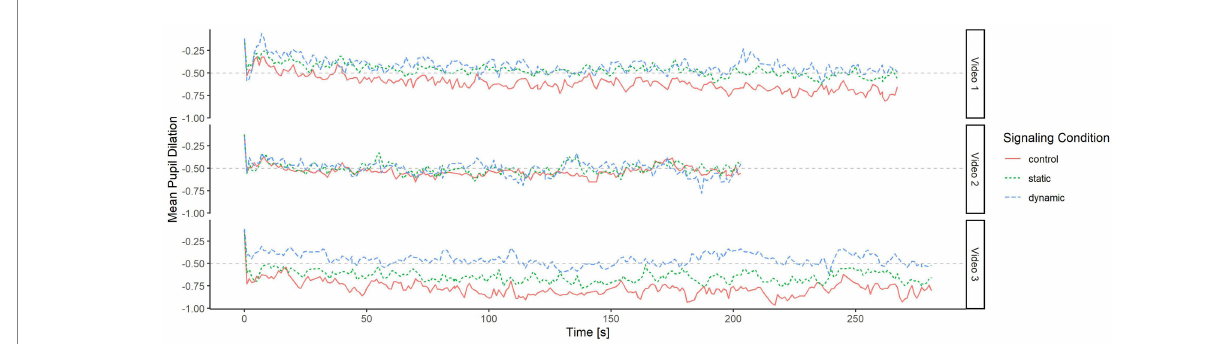
FIGURE 3 Pupil dilation over time per video and across different signaling conditions.